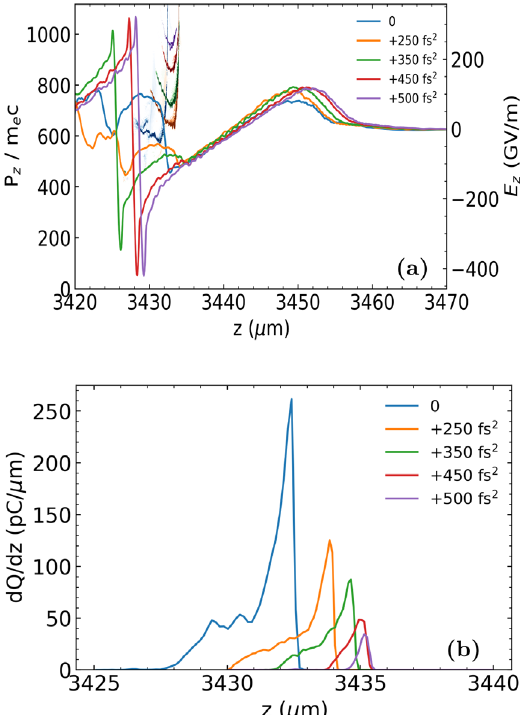
FIG. 5. Results from particle-in-cell simulations for different group delay dispersion ( ϕ ð 2 Þ ) values of laser pulse showing: (a) phase space and longitudinal on-axis electric field E z , and (b) longitudinal charge distribution of the injected electron bunch around z ¼ 3 . 5 mm. Electron bunches of different charge are injected by changing the temporal chirp ( ϕ ð 2 Þ ) of the laser pulse. Higher charges decrease the accelerating fields of the wakefields due to the effect of beam